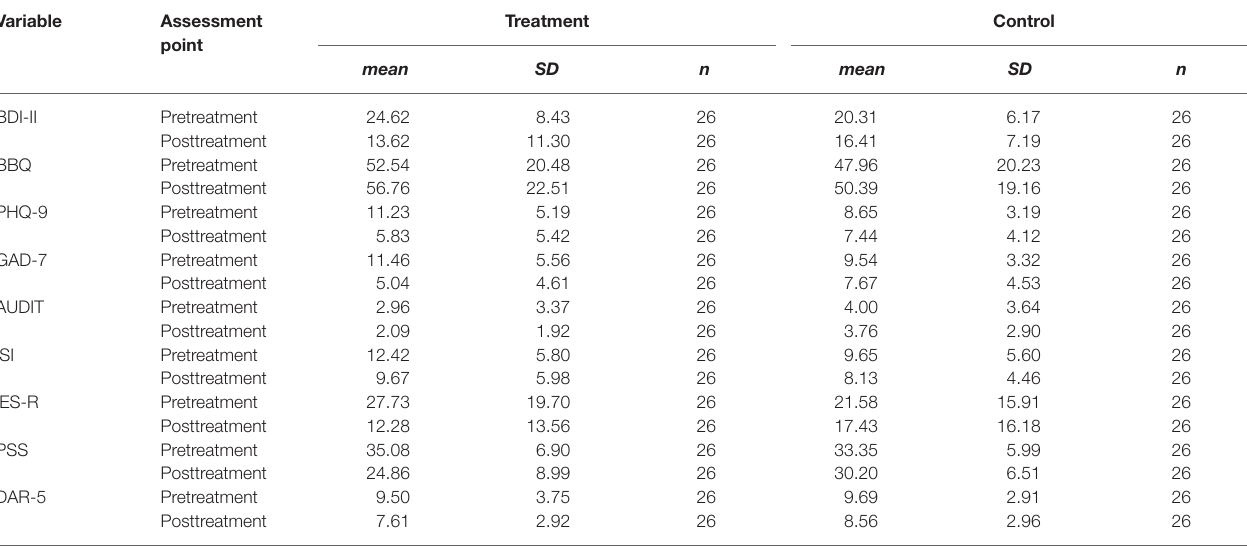
TABLE 2 | Imputed means, SDs, and the number of participants for each measure divided by condition and assessment point. Variable